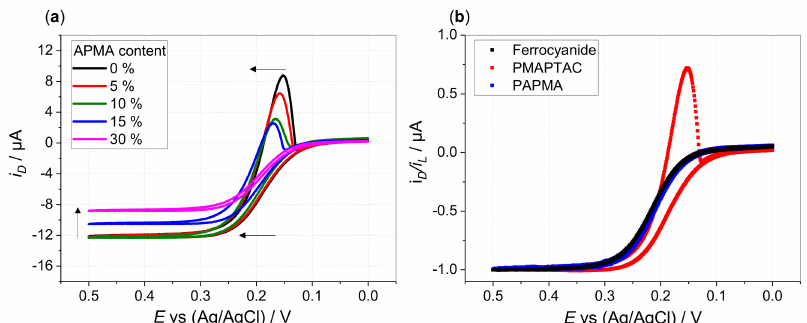
Figure 2. ( a ) Disk currents at 5000 rpm in hydrodynamic voltammograms of 0.13 mM HCF(II) in 0.1 M KCl (black line) in presence of 0.52 mM P(MAPTAC- co -APMA-x%) (with respect to quaternized units, icr = 1) with x% APMA content as indicated: 0% (black), 5% (red), 10% (green), 15% blue and 30% magenta (arrow indicates shift of voltammograms with increasing APMA content) and ( b ) disk currents normalized to limiting disk currents for hydrodynamic voltammograms of 0.13 mM HCF(II) in 0.1 M KCl in absence (black) and presence of 0.52 mM PMAPTAC (red) and PAPMA (blue) (with respect to quaternized units, icr = 1) (disk potential scanned from 0 to 0.5 V (forward scan) and back to 0 V (backward scan) vs. Ag/AgCl with ν = 5 mV/s).